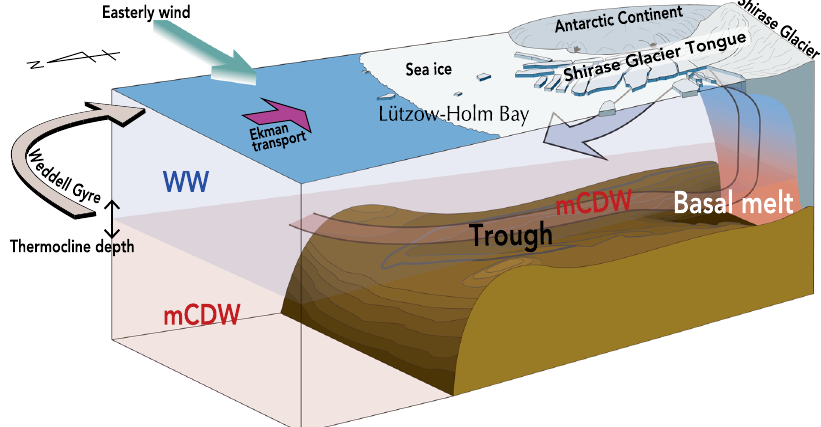
Fig. 8 Interaction between ocean and SGT, East Antarctica. The interaction (SGT basal melt process) comprises (1) transport of offshore-origin warm modi fi ed Circumpolar Deep Water (mCDW) into Lützow-Holm Bay located in the southeastern part of cyclonic Weddell Gyre, (2) southward in fl ow of warm mCDW along deep layer of the trough and fi nally into the region beneath SGT, (3) SGT basal melt by in fl owing warm mCDW and buoyant meltwater plume of glacial meltwater together with mCDW, and (4) northwestward out fl ow of a mixture of glacial meltwater and mCDW above subsurface layer from beneath SGT. Alongshore easterly wind, mediated by surface Ekman dynamics, fl uctuates the depth of the thermocline between Winter Water (WW) and mCDW, that is, controls the thickness of warm water in fl ow into the bay and the magnitude of subsequent basal melting beneath the